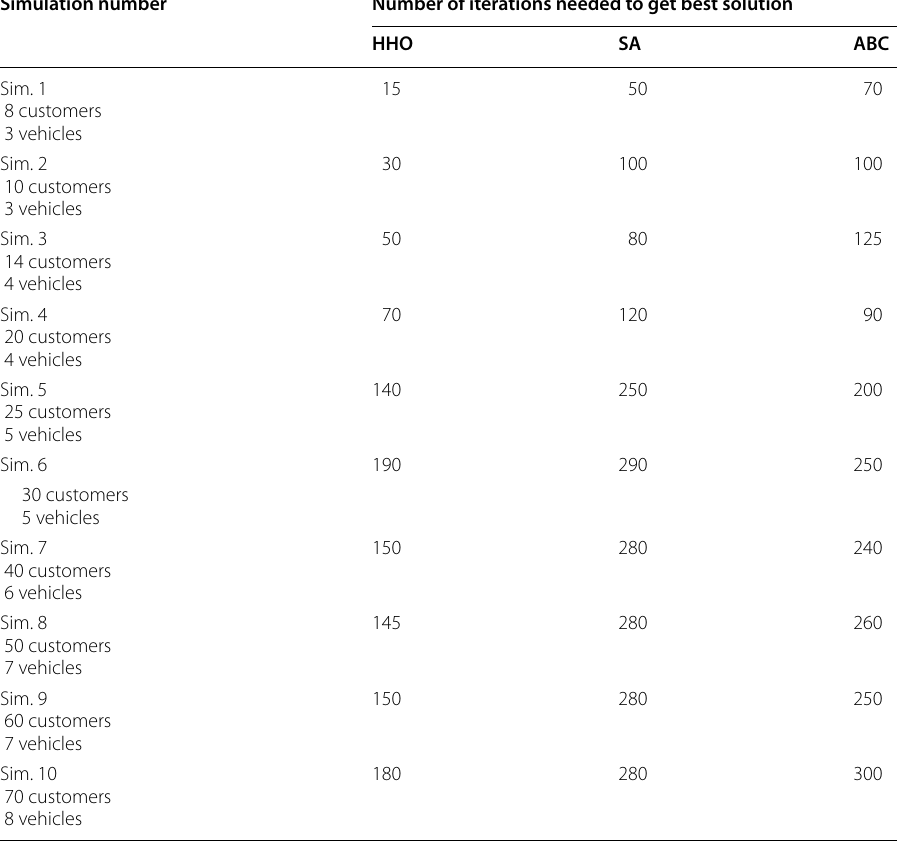
Table 5 Number of iterations needed to get best solution Simulation number Number of iterations needed to get best